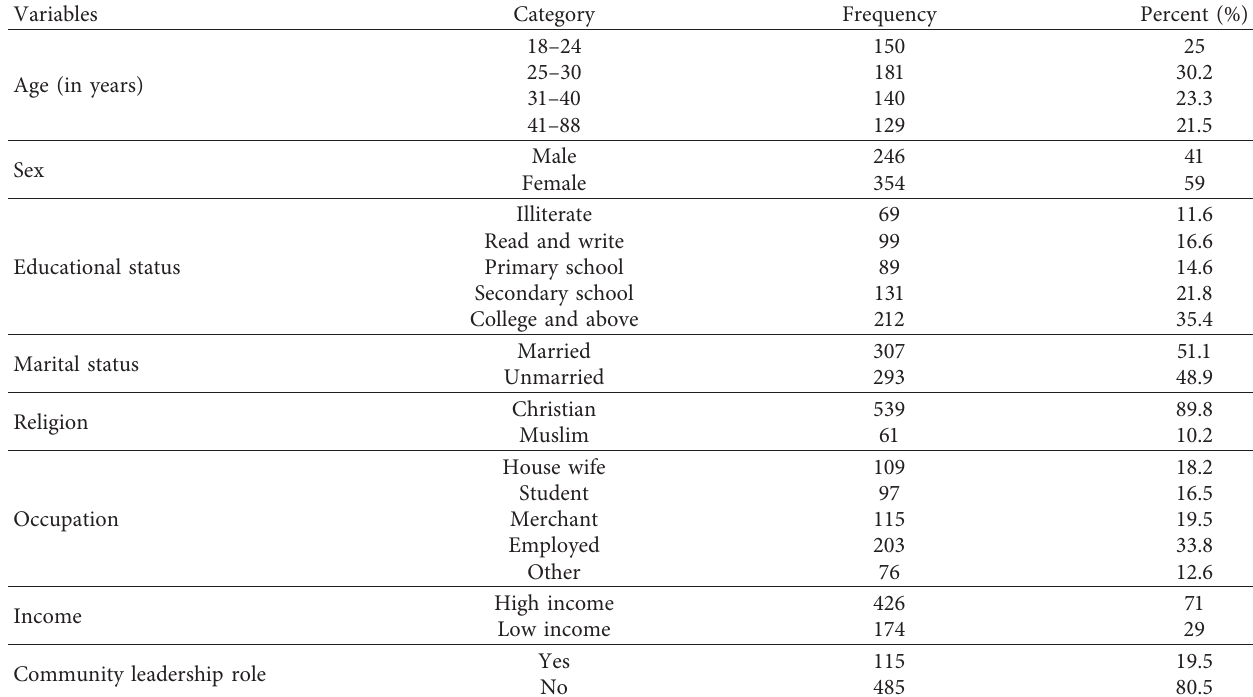
Figure 1: Multistage sampling which illustrates the sampling procedure to draw the study samples from source population. Table 1: Sociodemographic characteristics of study participants towards practice of traditional eye medicine among adult residents in Gondar city, North West Ethiopia, 2017 ( n � 600, n � study